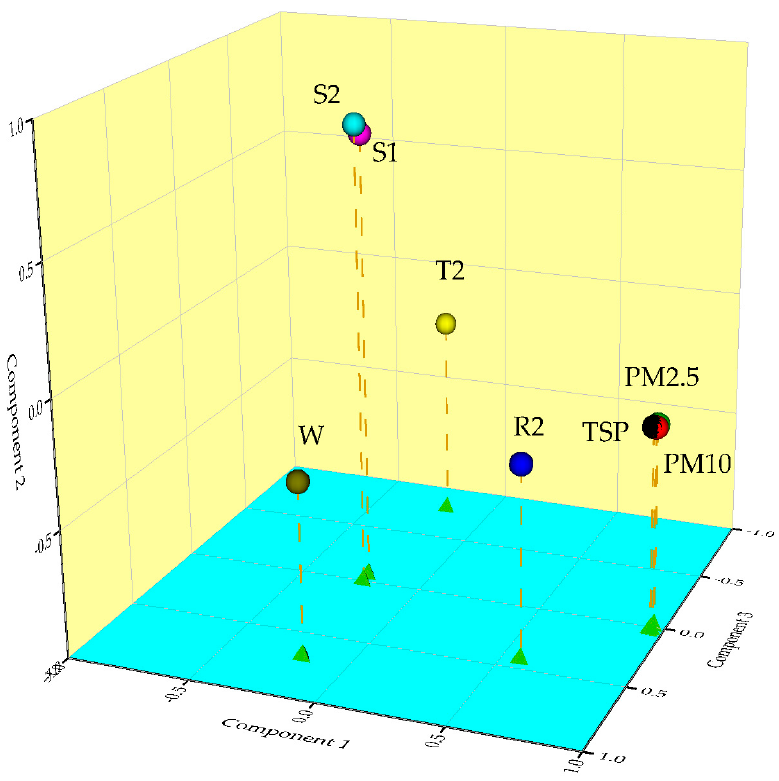
Figure 8. Principal component analysis plot showing three principal components. Table 13. Regression model of PM